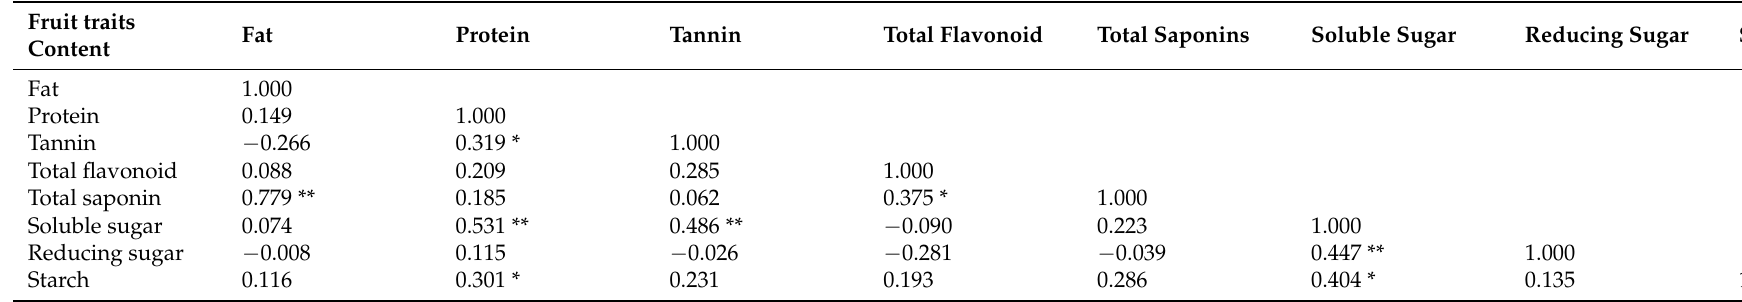
Table A2. Correlation analysis between fruit quality traits of H. acerba